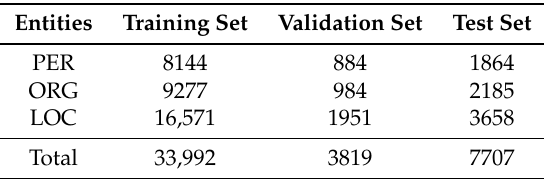
Table 1. The summary of the MSRA-NER.